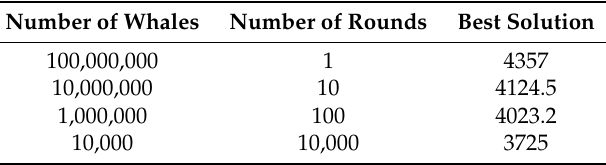
Table 12. The best solution of DS 8 for di ff erent